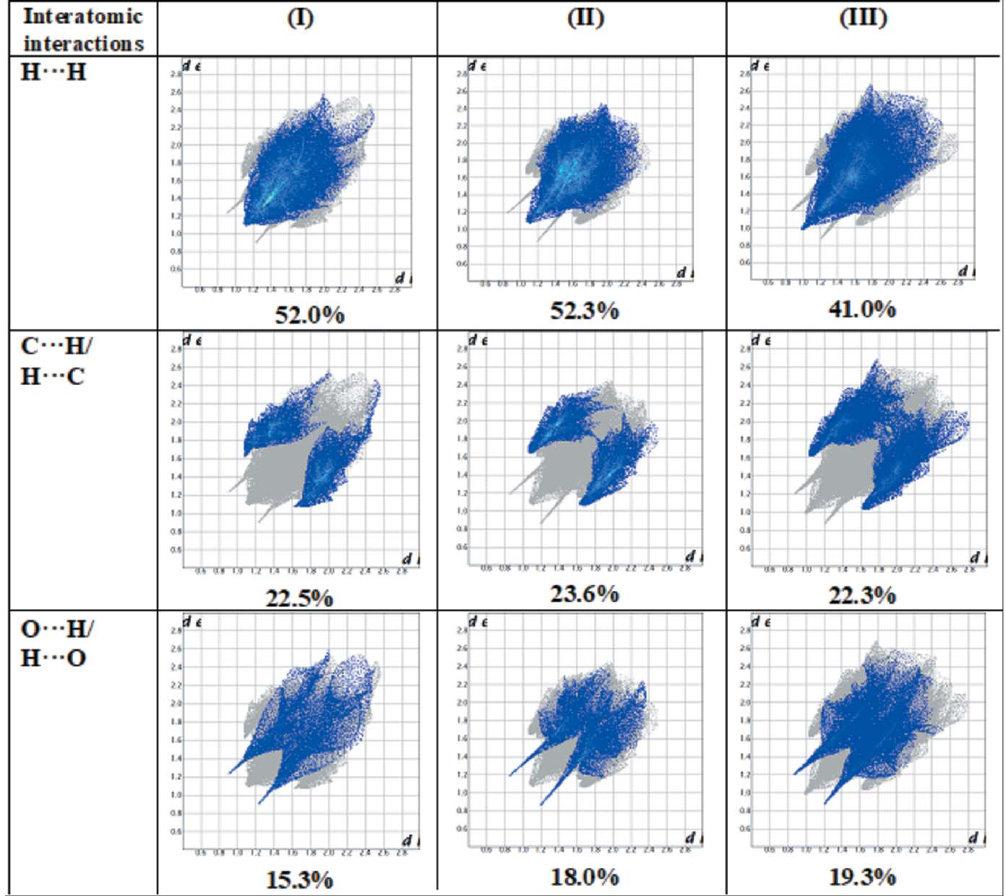
Figure 11 Two-dimensional fingerprint plots for (I), (II) and (III), showing the contributions of the different types of